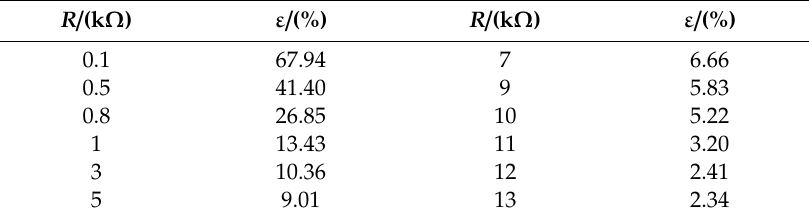
Figure 10. Relationship between resistor divider and the voltage error. Table 1. Relationship between the resistor divider and voltage error.